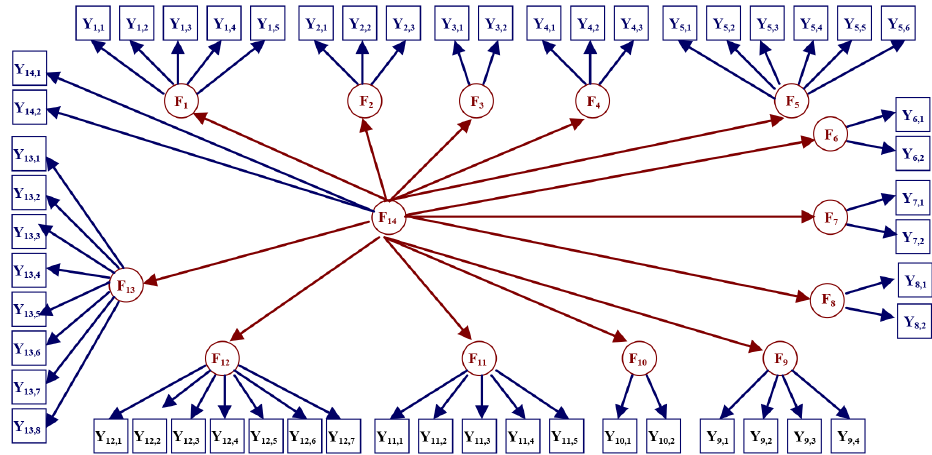
Fig. 1. Sequence diagram of the